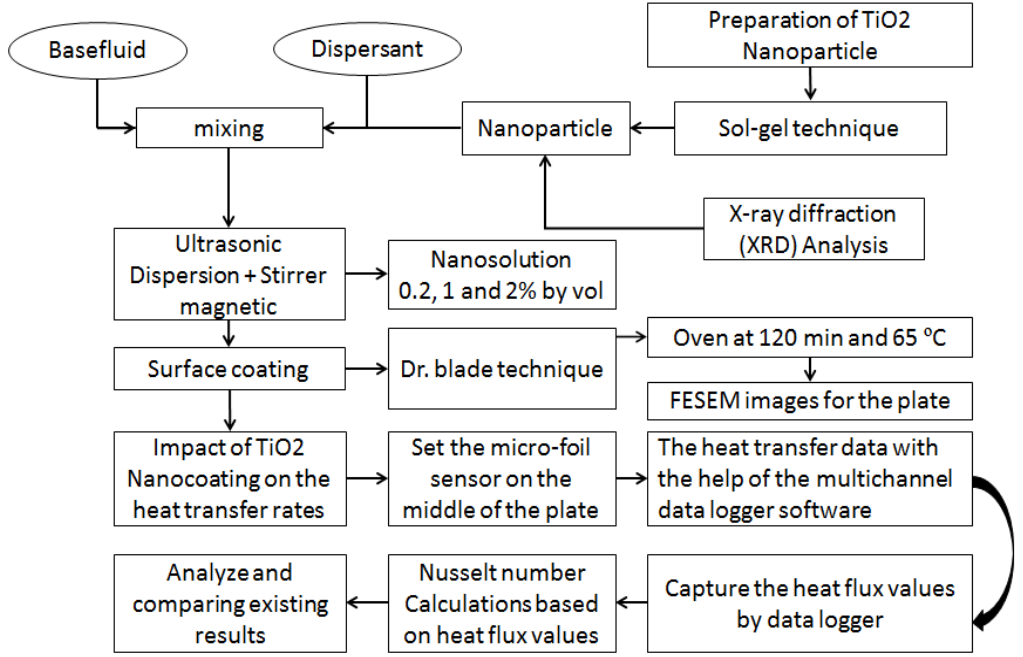
Figure 3. Flow chart of experimental procedure and methodology of twin-impingement jet test setup.